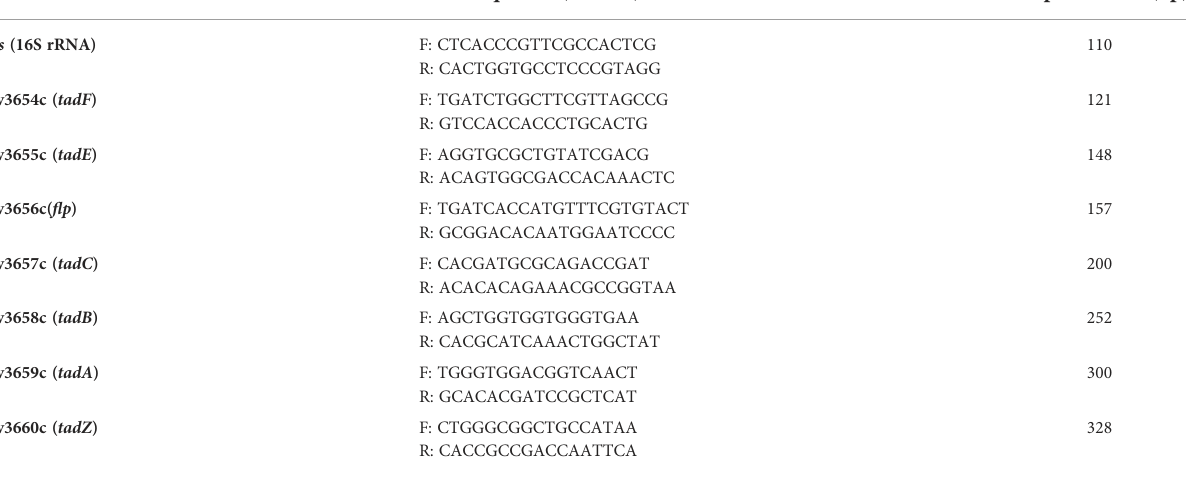
TABLE 1 Primers for qPCR ampli fi